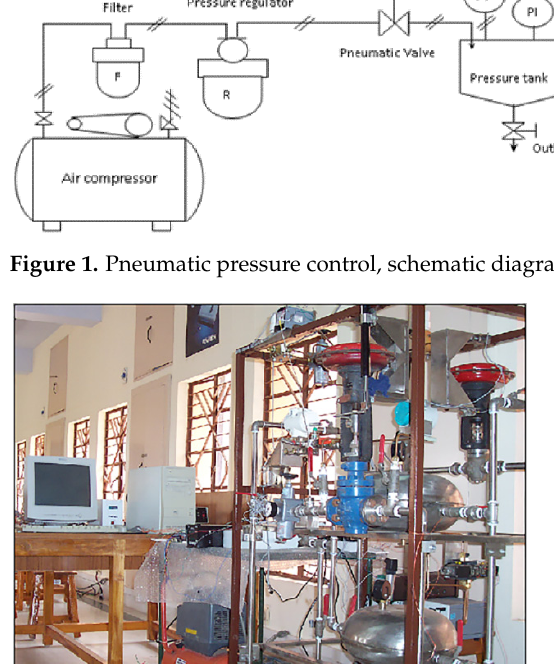
Figure 2. Picture of pneumatic pressure control experimental setup.